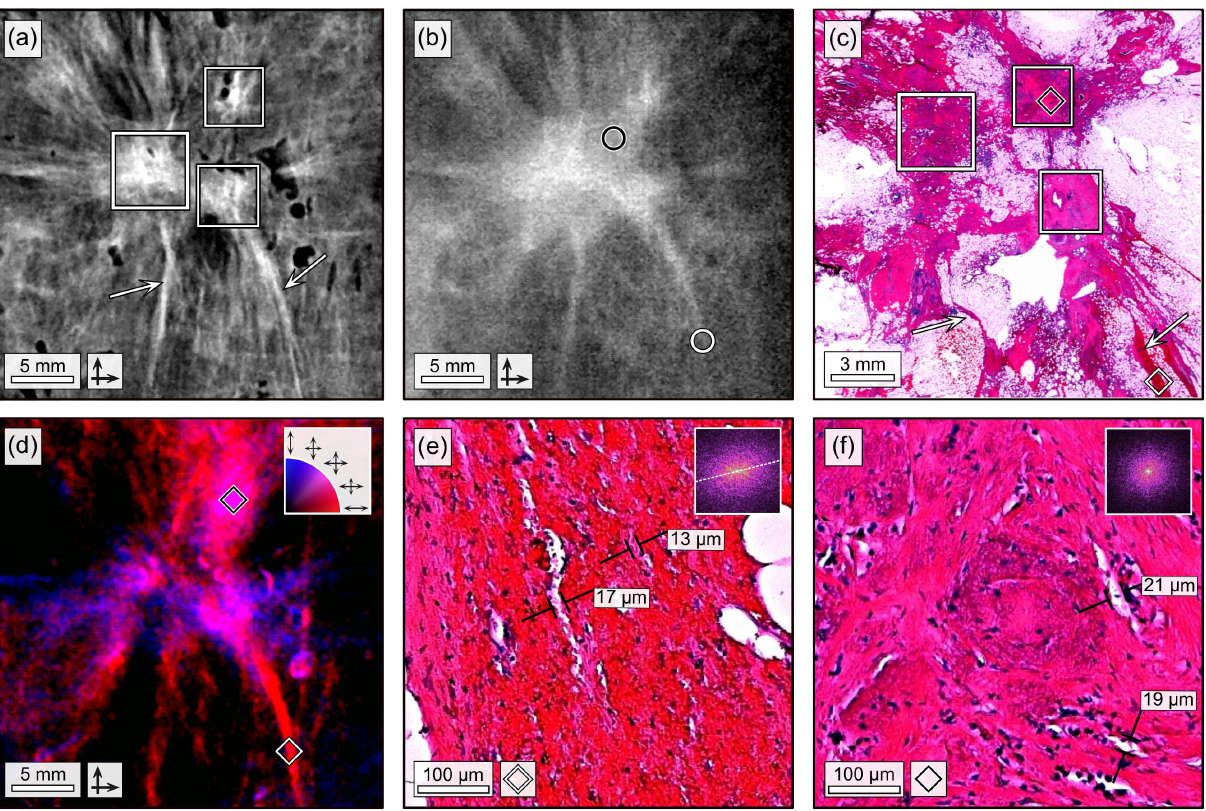
Figure 4. Two-directional, grating-based mammograms of the invasive ductal carcinoma with correlated histopathology. (a) Sharpened, two-dimensional integrated phase image W s of the invasive ductal carcinoma. The frames in (a) and (c) indicate three locally separated tumor lesions (apparently trifocal). Arrows in (a) and (c) indicate fine tumor branches. (b) Sharpened, absorption image A s of the invasive ductal carcinoma. Circles indicate position of relevant tumor details. (c) Histological slice (Hematoxylin and Eosin stain) of the invasive ductal carcinoma. (d) Directional dark-field image of the invasive ductal carcinoma. Preferred scattering direction is color-coded ranging from x -directed (red) over isotropic (purple) to y -directed (blue). (e) 200x magnified histological image of the tumor branch, as indicated by white diamond in (c) and (d). The 2- dimensional FFT is shown as an inlay. (d) 200x magnified histological image of the tumor lesion, as indicated by black diamond in (c) and (d). The 2- dimensional FFT is shown as an inlay.